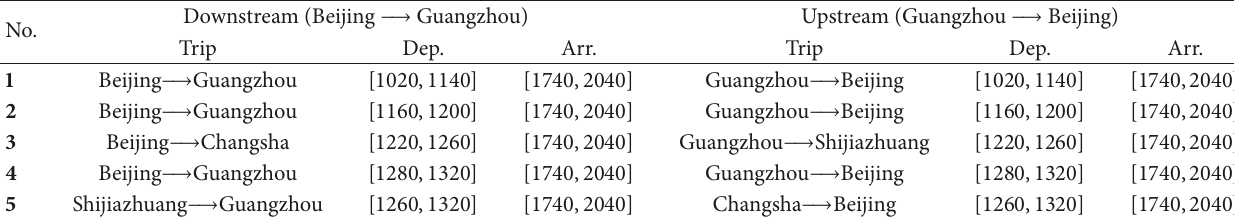
Table 5: The parameters of SDSA-trains.